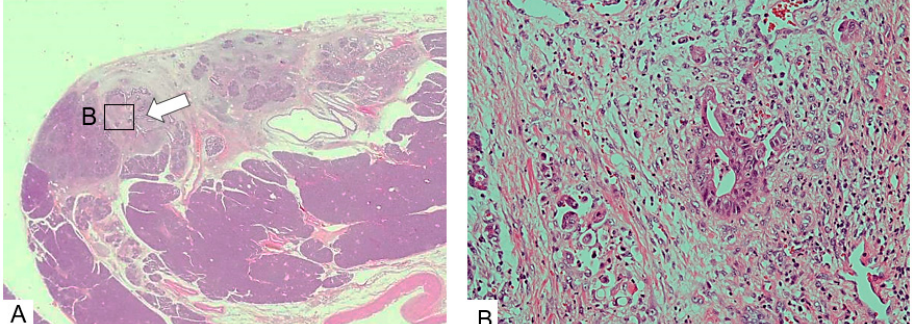
Figure 4. Simple stricture type. ( A ) The main pancreatic duct (arrow) is strictured and surrounded by dense fibrous stroma. ( B ) The epithelium changes to a dysplastic one with an invasive part within a minimal area of 3 mm. (Hematoxylin and eosin stain (H.E), ×100). Copyright information © Japan Pancreas Society 2017 [14].